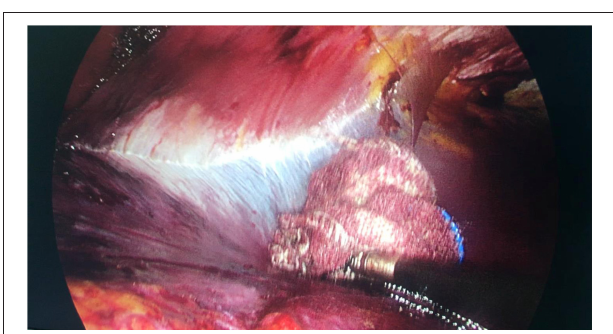
FIGURE 5 | Blunt separation of gauze